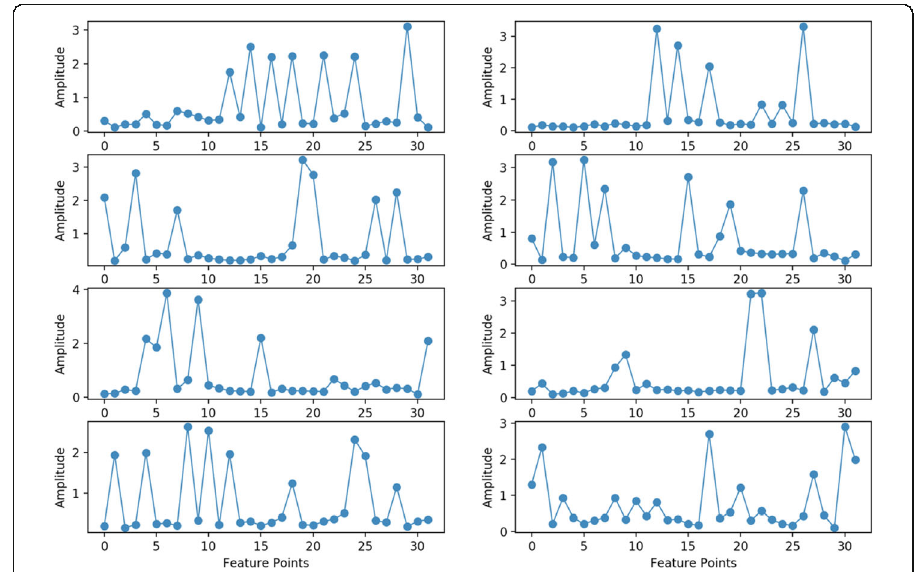
Fig. 14 batch chip feature map of A1631